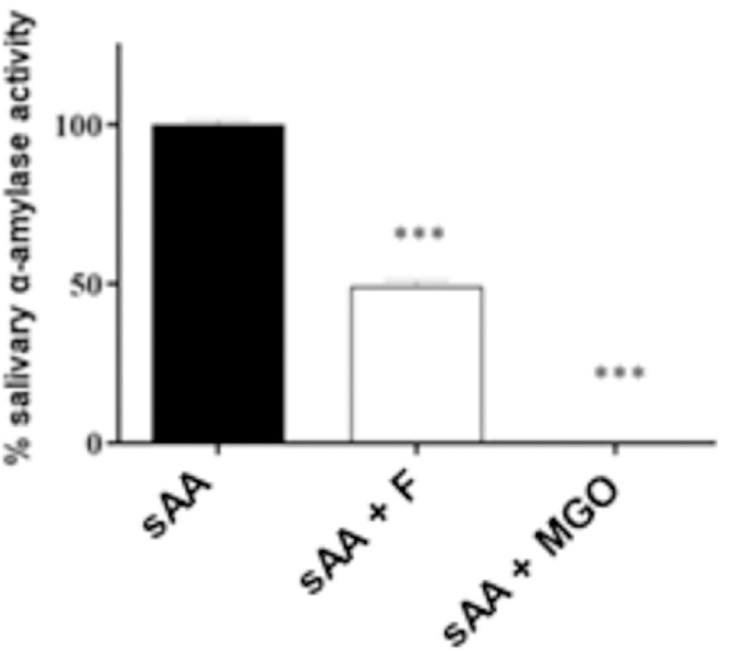
Fig 7. Enzymatic activity of non-glycated sAA, and glycated by fructose or MGO. ��� p < 0,001.